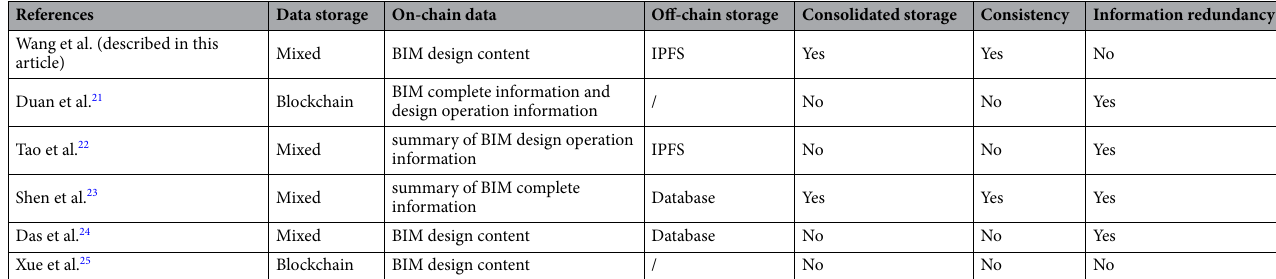
Table 1. Research on the combination of blockchain and BIM multi-person collaborative